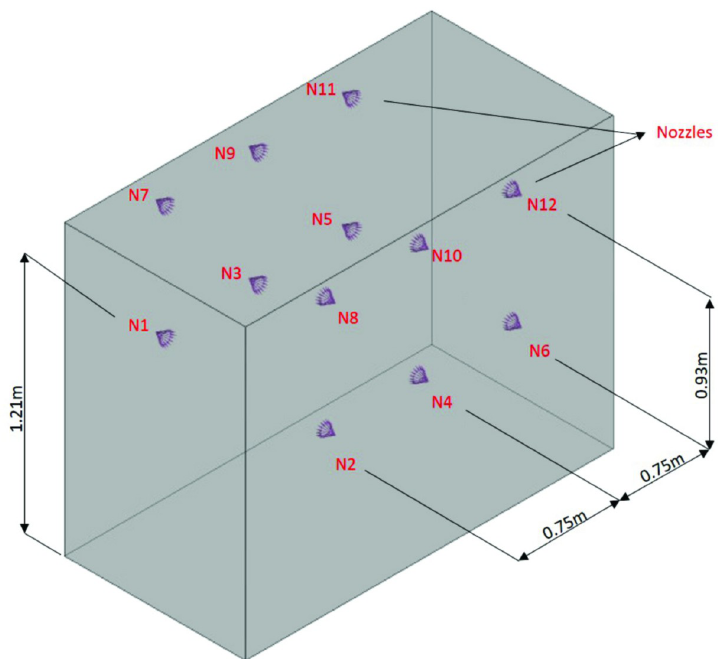
Fig 19. New proposed configuration for the disinfection chamber designed with 12 nebulizer